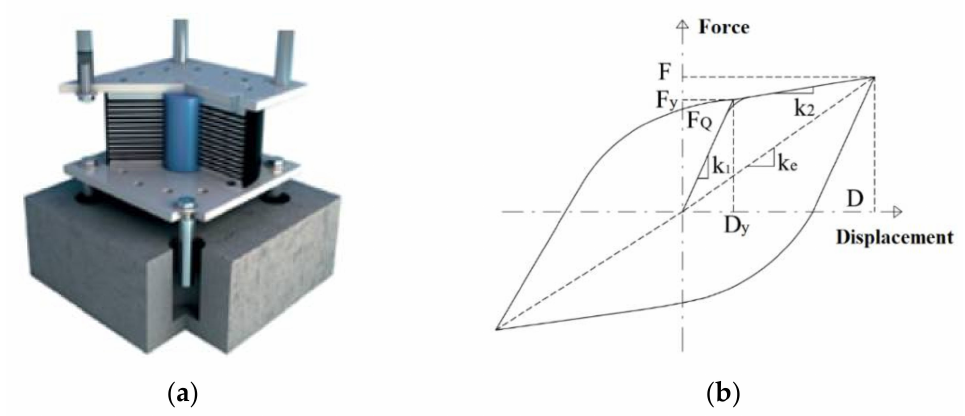
Figure 6. ( a ) Lead rubber bearing [39] and ( b ) force–displacement behavior